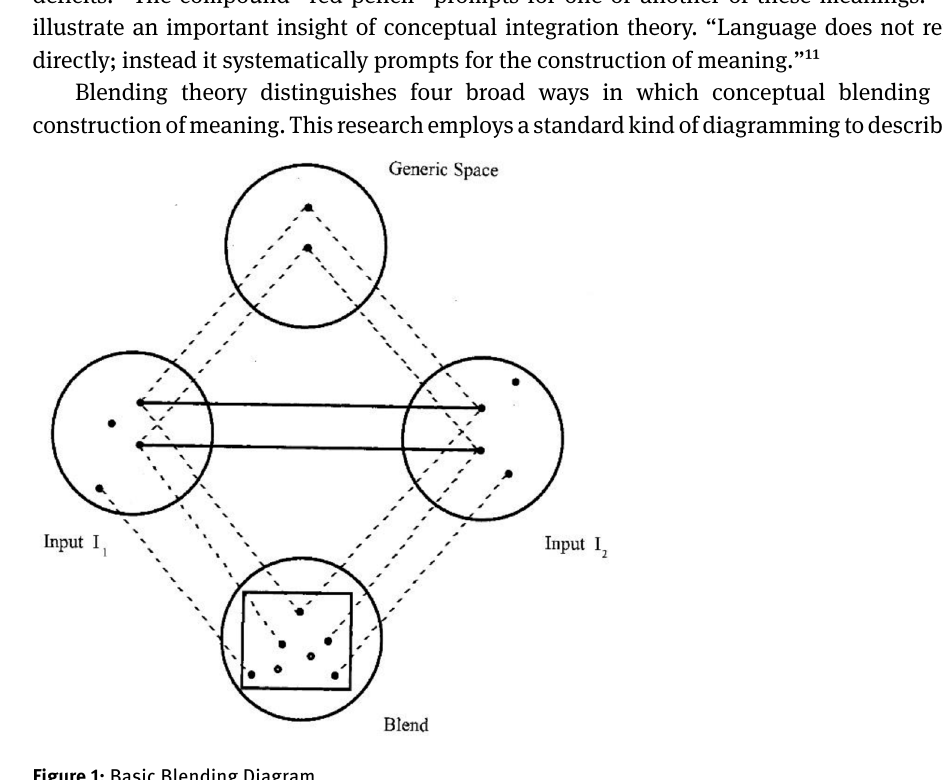
Figure 1: Basic Blending Diagram The basic diagram includes four spaces represented by circles. The two circles on either side designate the input spaces. The generic space at the top of the diagram indicates what the two inputs have in common. The circle on the bottom indicates the blend. The solid lines indicate cross-space mappings between the inputs. The dotted lines indicate connections between the inputs and either the generic or blended